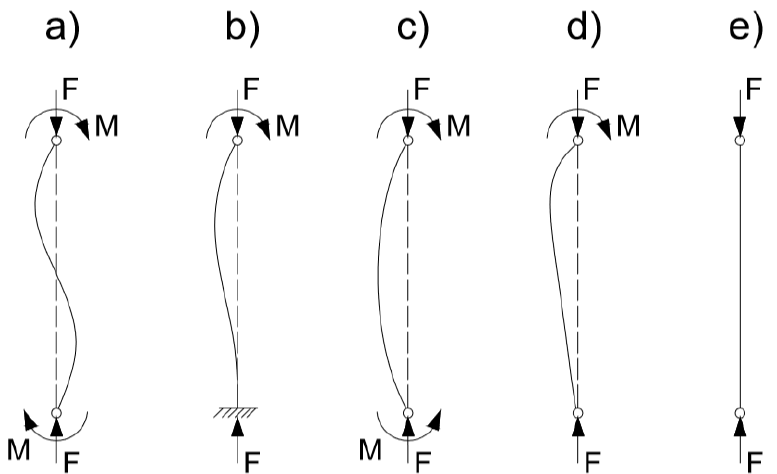
Figure 6. Load cases investigated by Kuren and Galambos; simply supported beam-column with unequal end moments ( a ); pinned-fixed beam-column ( b ); simply supported beam-column with equal end moments (c) ; simply supported beam-column with linear bending moment distribution ( d ); centrically loaded beam-column ( e ) .